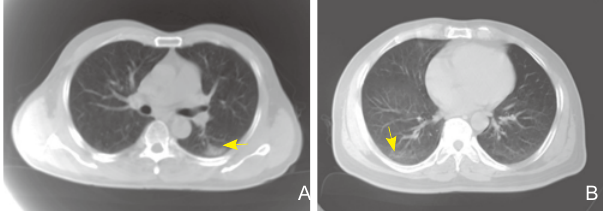
Figure 3 CT image features of lungs in asymptomatic confirmed patients with COVID-19. (A) CT showed ground-glass opacity with thickened interlobular septal in the left lower lobe, involving the pleura, and sign of air bronchus (arrow); (B) CT showed flocculent high-density shadow at the base of both lungs, especially in the right lung (arrow).